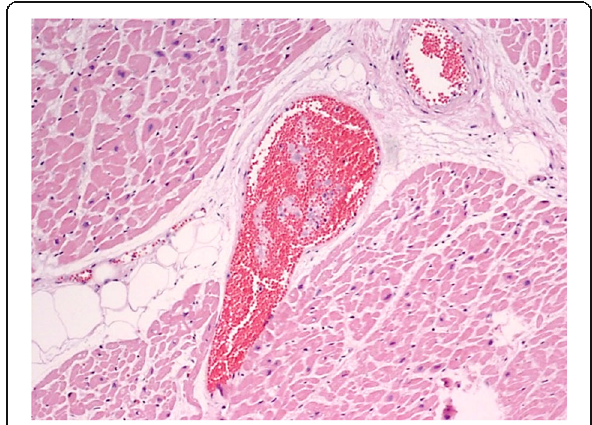
Fig. 2 Myocardial vascular microthrombosis (hematoxylin and eosin